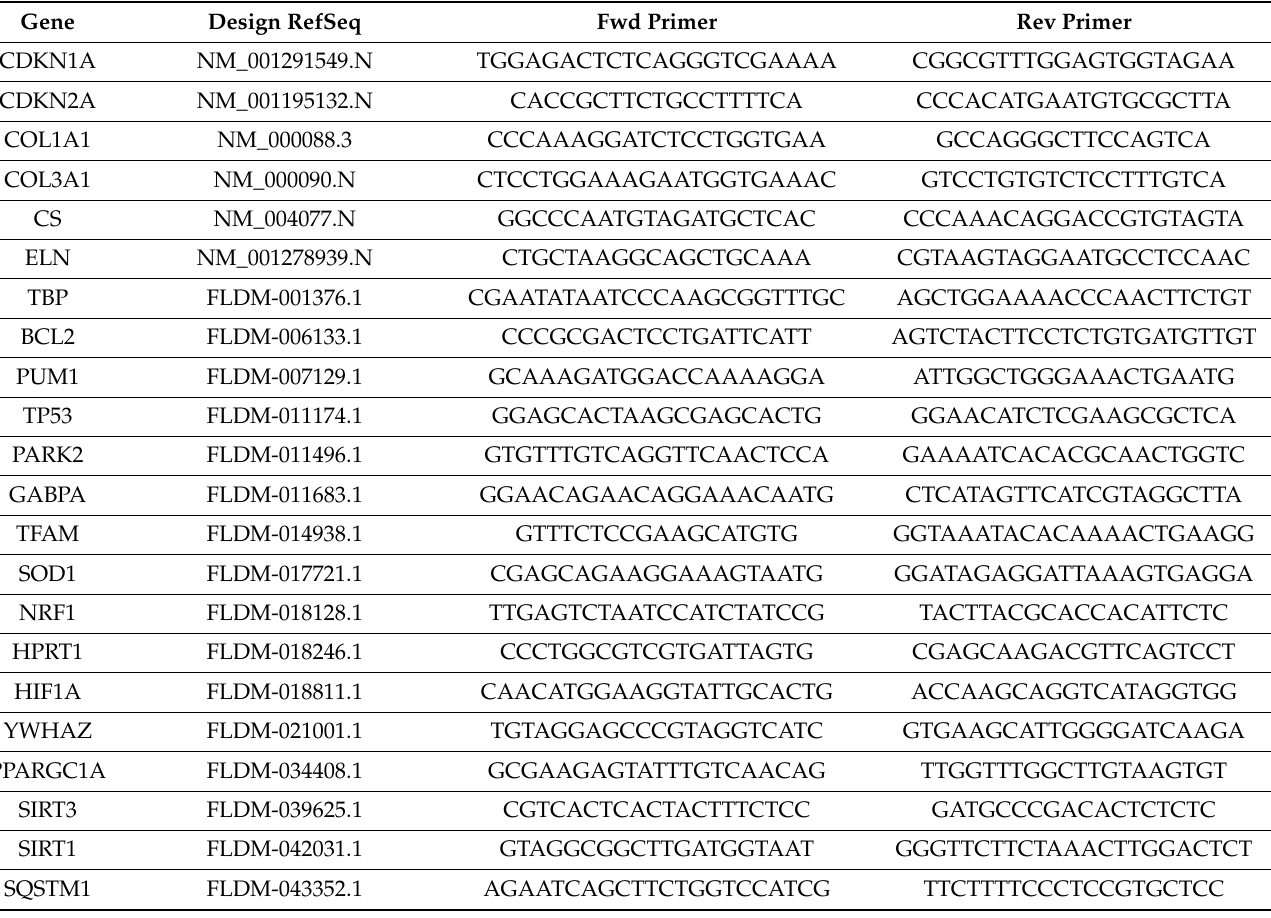
Table 2. List of primers used in this